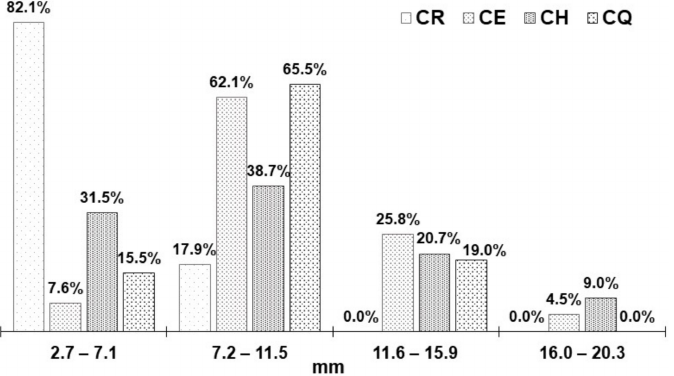
Figure 1. Fresh nostoc diameter.